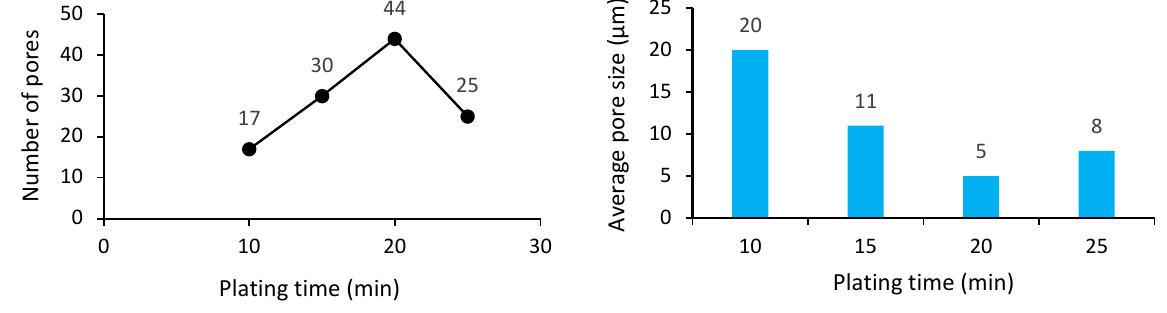
Fig.6 . Variation in number of pores and Size of the largest pore with plating